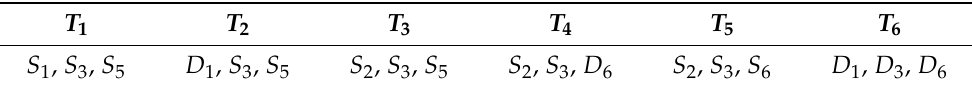
Table 5. Conduction of switches in different time intervals in Fuel cell to DC–link and battery charging in buck-boost